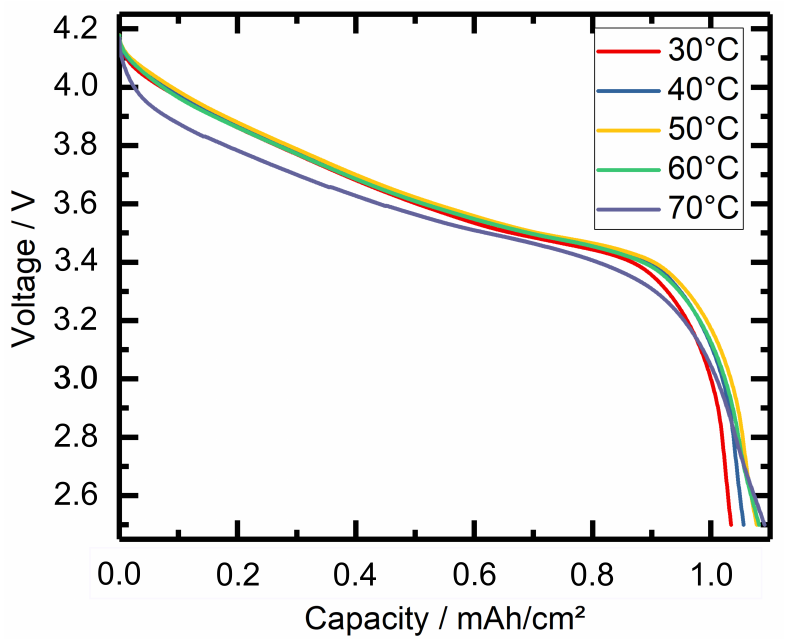
Figure 4. Voltage profiles at different temperatures of a graphite/NCM cell with 1 M LiTFSI in TBAC:EC:EMC:DEC (60:15:5:20 wt)